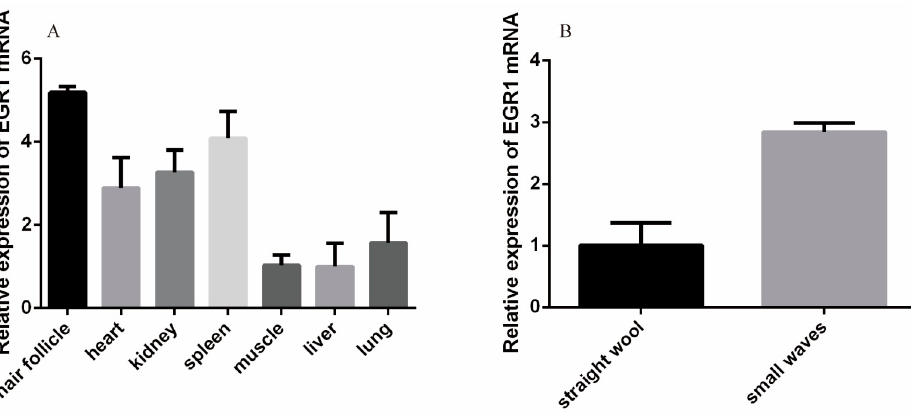
Figure 3. Expression level analysis of EGR1 . ( A ) Expression profiles of EGR1 in different tissues. ( B ) Expression of the EGR1 gene in different patterns.